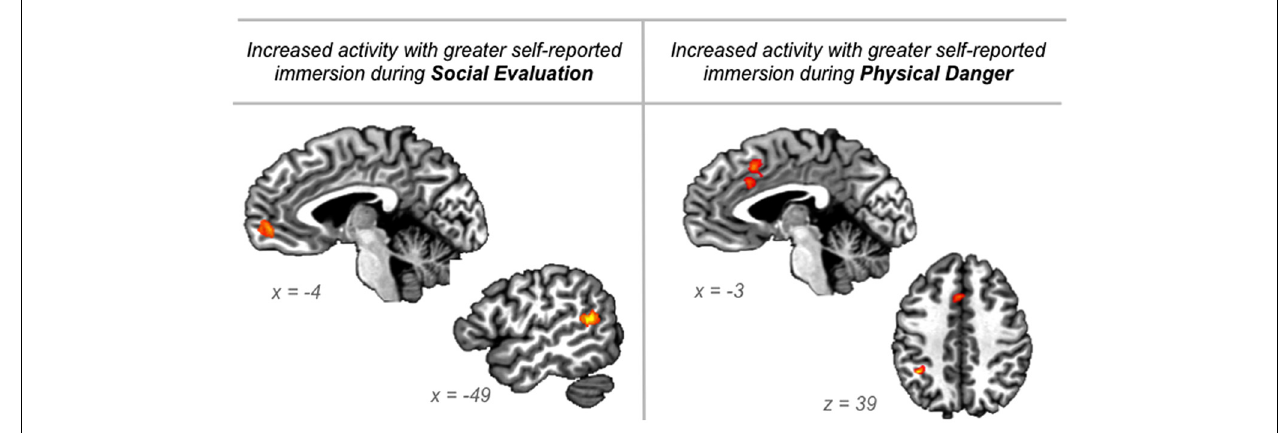
FIGURE 6 | Regions in which neural activity was significantly correlated with participants’ “being there” ratings of immersion collected during the training session just prior to scanning, for the social evaluation situations and for the physical danger